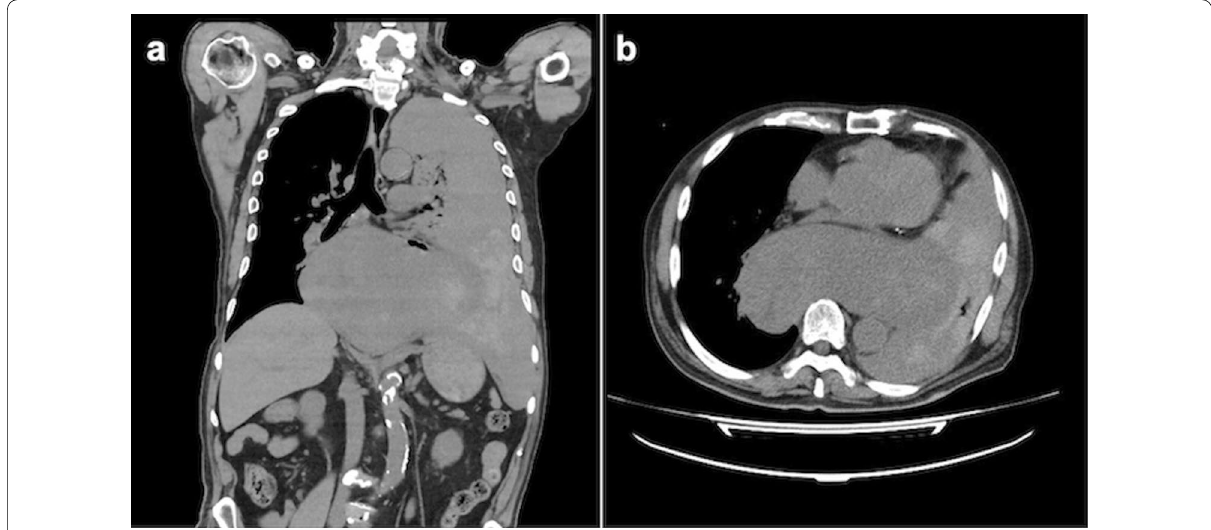
Fig. 1 Plain computed tomography of the chest showing mediastinal enlargement and left hemothorax: a coronal, b